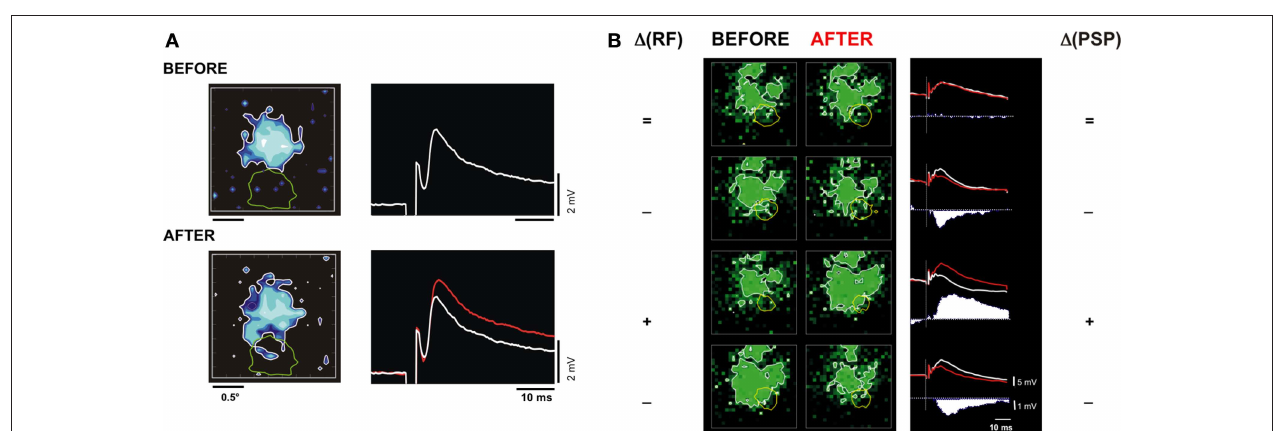
Figure 6 | interaction between theta-burst and supervised Hebbian pairings: case examples. Three examples of the effects of TBS_S + protocols, where a brief (4 ms) intracellular current pulse is added in phase with the 1st [cells (A) , (B) , and (C) ], 2nd or 3rd [cells (B) and (C) ], or 5th (cells (B) and (C) ] electrical shock of the high frequency thalamic burst (black arrow heads). Both averaged PSPs (upper graphs) and PSTHs (lower histograms), recorded in response to a low frequency electrical thalamic shock (vertical line) before and after pairing, are represented with the same color codes [black for CONTROL,